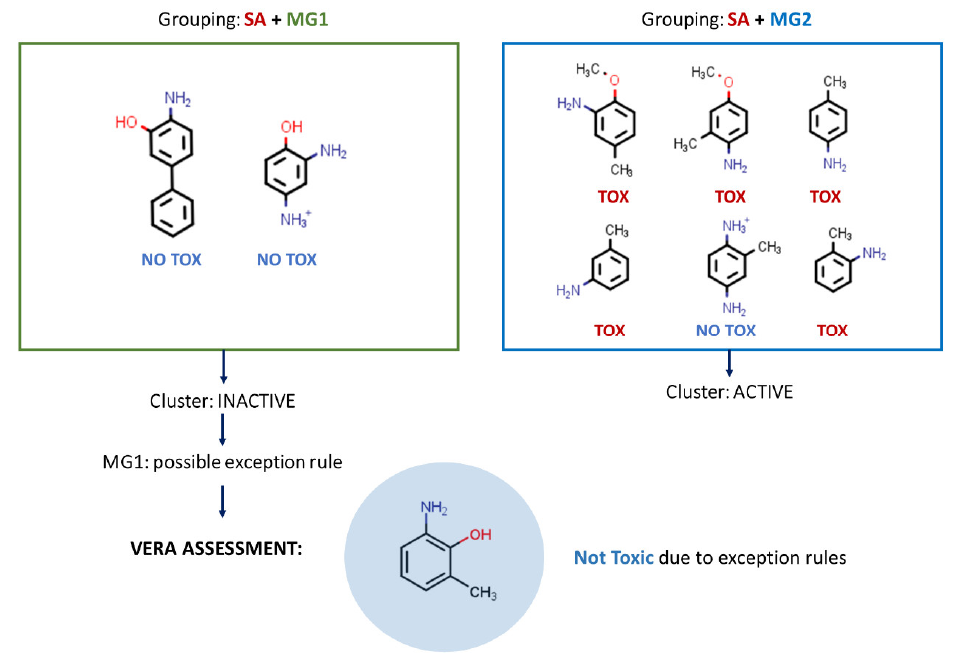
Figure 2. Reasoning within the VERA algorithm. For the SA in the target molecule, the algorithm analyses the co-presence of SA and MGs for similar compounds to assess the toxicity of the target and searches for any exception rules that may modulate toxicity. In the example of the figure, VERA found MG1 as an exception rule.